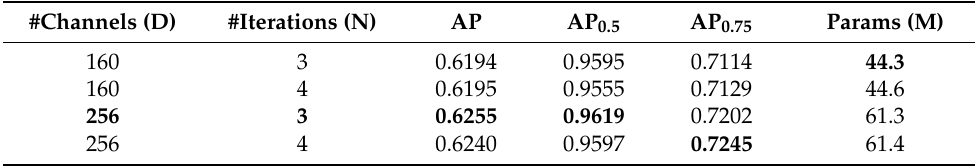
Figure 12. Comparison results of the methods with and without WCFF. The spring-green rectangles represent the detection results. The orange and blue circles represent the false alarms and the missing ships. ( a ) Results of the baseline. ( b ) Results of the baseline with WCFF. Table 7. Results of varying the output channels and iterations of WCFF